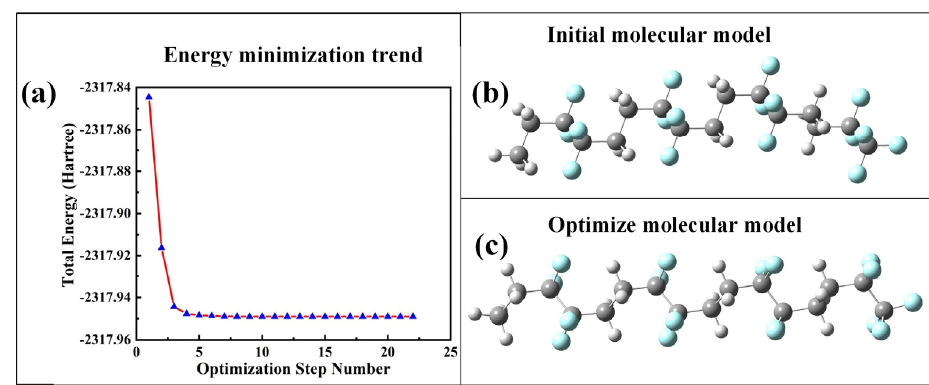
Figure 3. Molecular model of the α phase of PVDF.